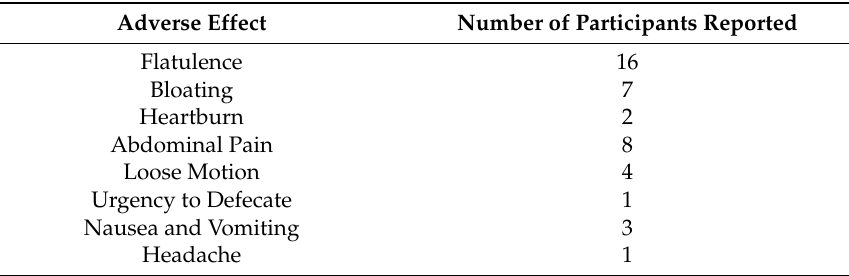
Table 1. Table of reported adverse effects over the 28-day